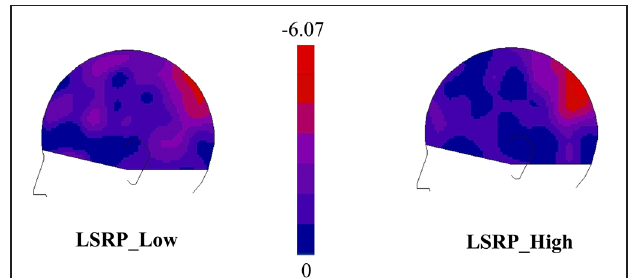
FIGURE 3 | Subtraction maps created to identify the ROI electrodes [66-67-71, in the EGI system (HCGSN) corresponding to P3 in the 10–20 systems] in which the somatosensory gating (SG) was showing the greatest modulation during the first two pictures (0:1000 ms) in comparison to the Cross Baseline ( − 1000:0